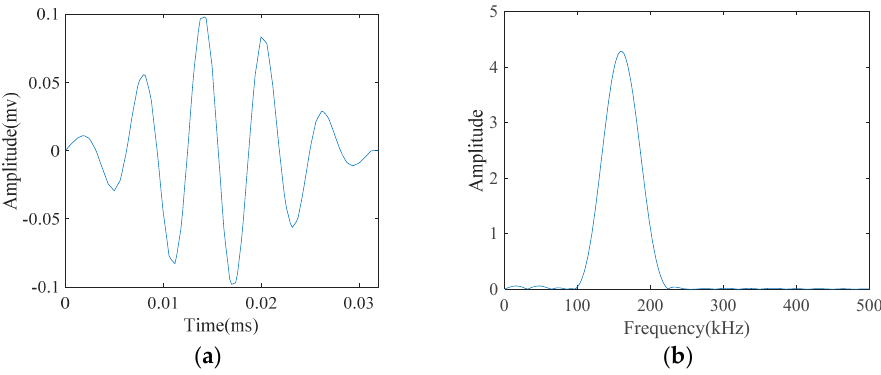
Figure 4. The desired five-cycle tone-burst emitted at 160 kHz as the center frequency in: ( a ) its temporal waveform; and ( b ) its spectrum.